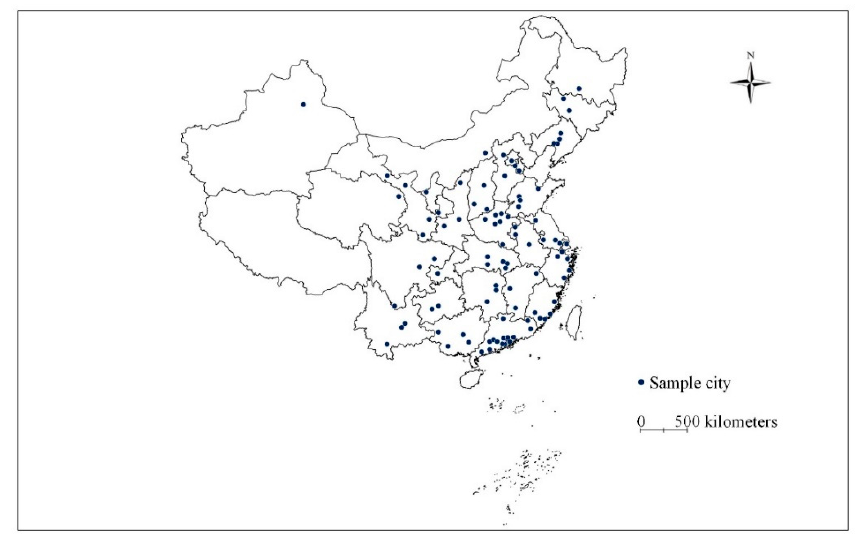
Figure 2. Distribution of the sample.